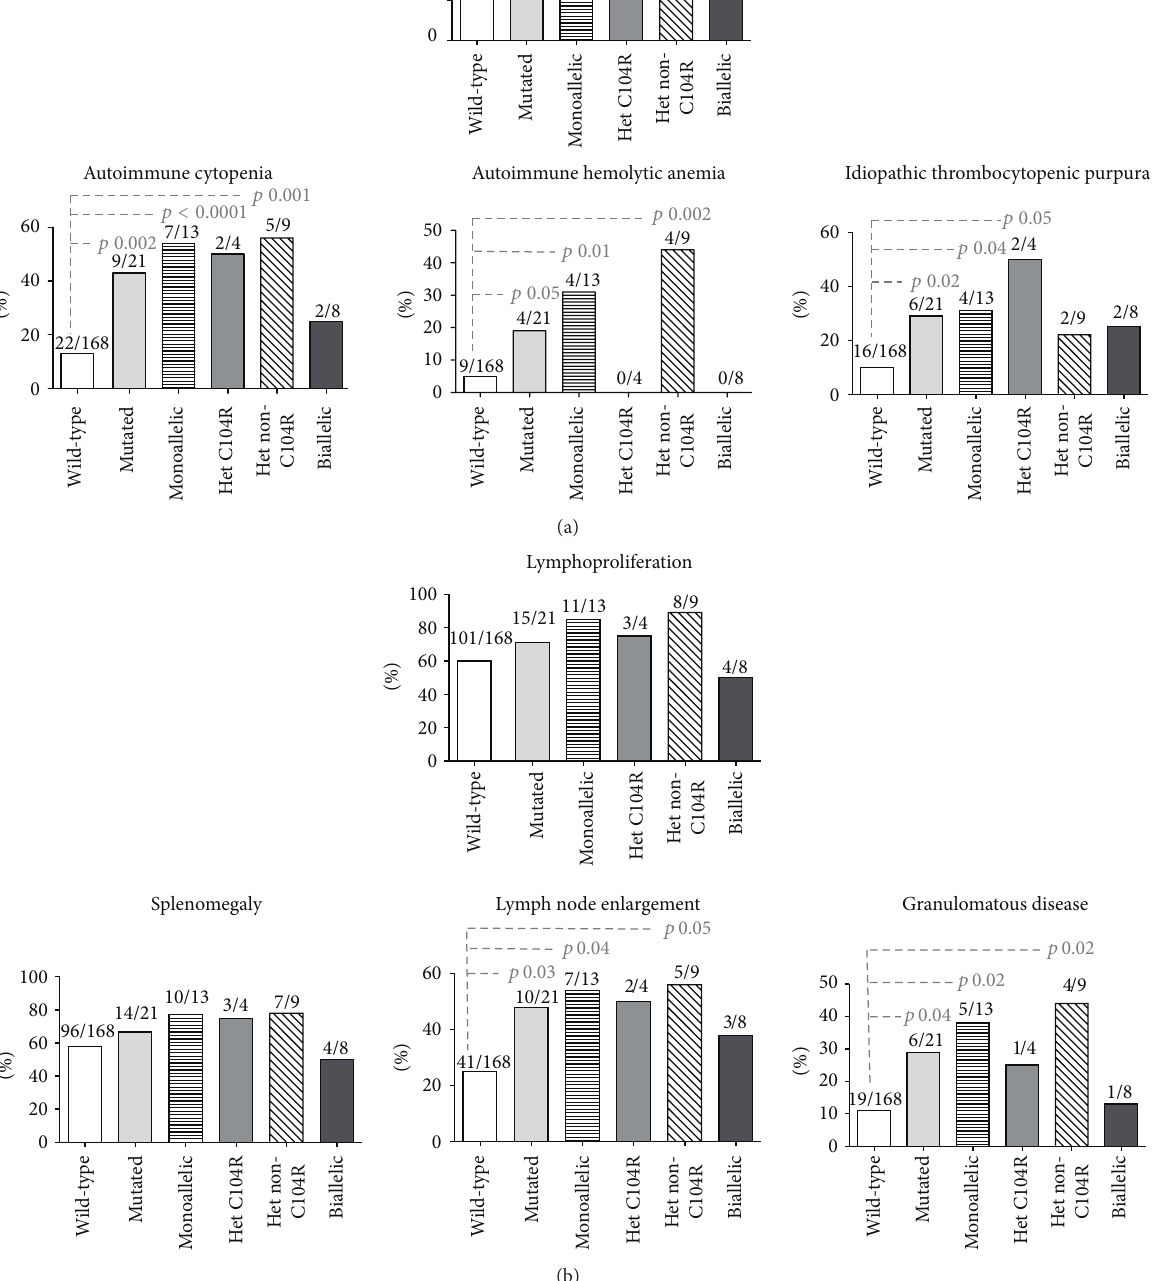
Figure 2: Autoimmune (a) and lymphoproliferative (b) complications in patients with TACI wild-type or mutated sequence. TACI-deficient individuals were grouped as carrying monoallelic TACI mutations (heterozygous C104R and heterozygous non-C104R) and biallelic TACI